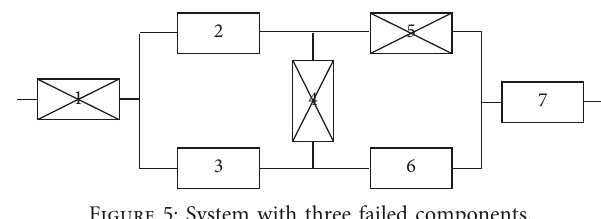
Figure 5: System with three failed